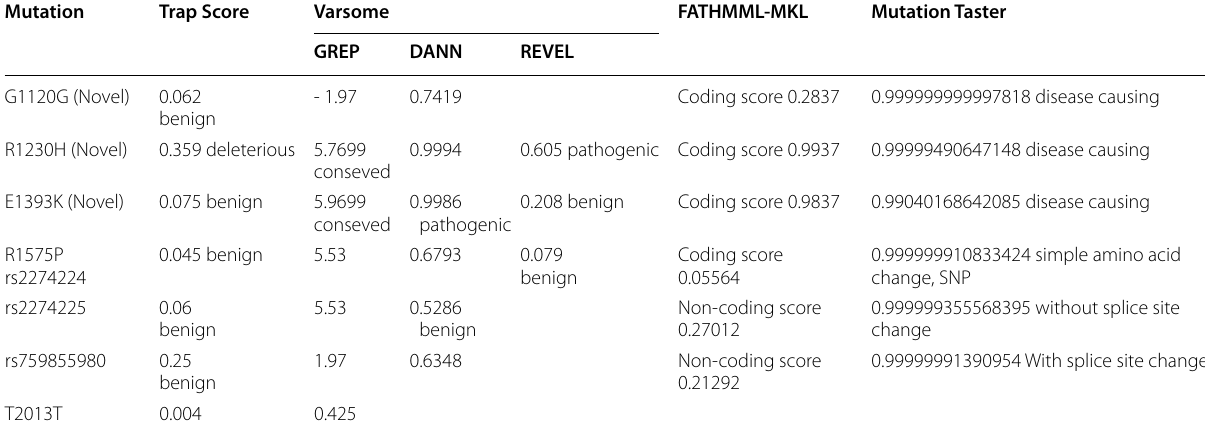
Non-coding:( positions in intergenic regions, introns or non-coding genes), coding: (positions within coding-sequence exons). GERP:Genomic Evolutionary Rate Profiling (GERP): It ranges from -12.3 to 6.17, with 6.17 being the most conserved. DANN Score is a pathogenicity scoring methodology from 0 to 1 being highly